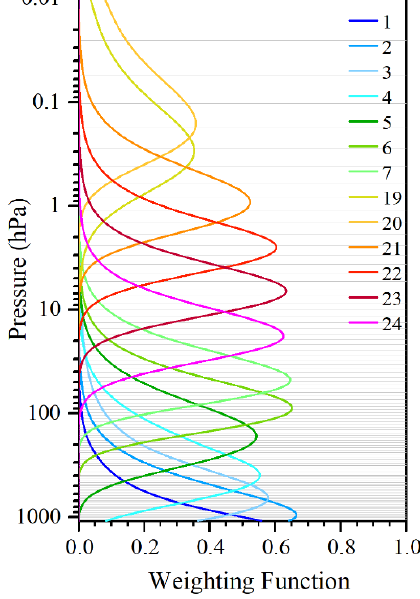
Figure 1. Vertical profiles of weighting functions of SSMIS atmospheric temperature sounding channels, which are calculated from the US standard atmosphere profile using Community Radiative Transfer Model (CRTM, version 2.3.0).